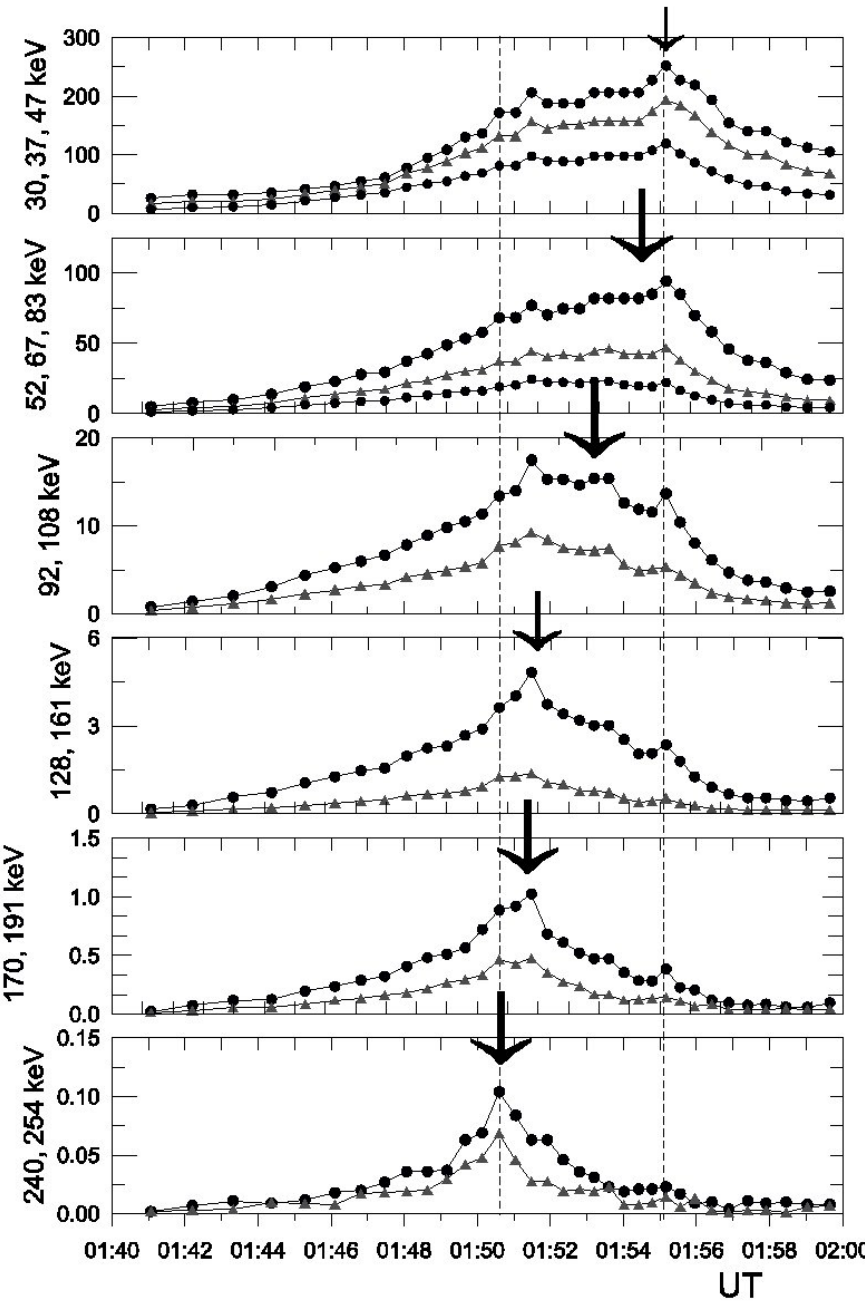
Fig. 4. Similar format as in Fig. 1. Dispersive electron flux increase observed at